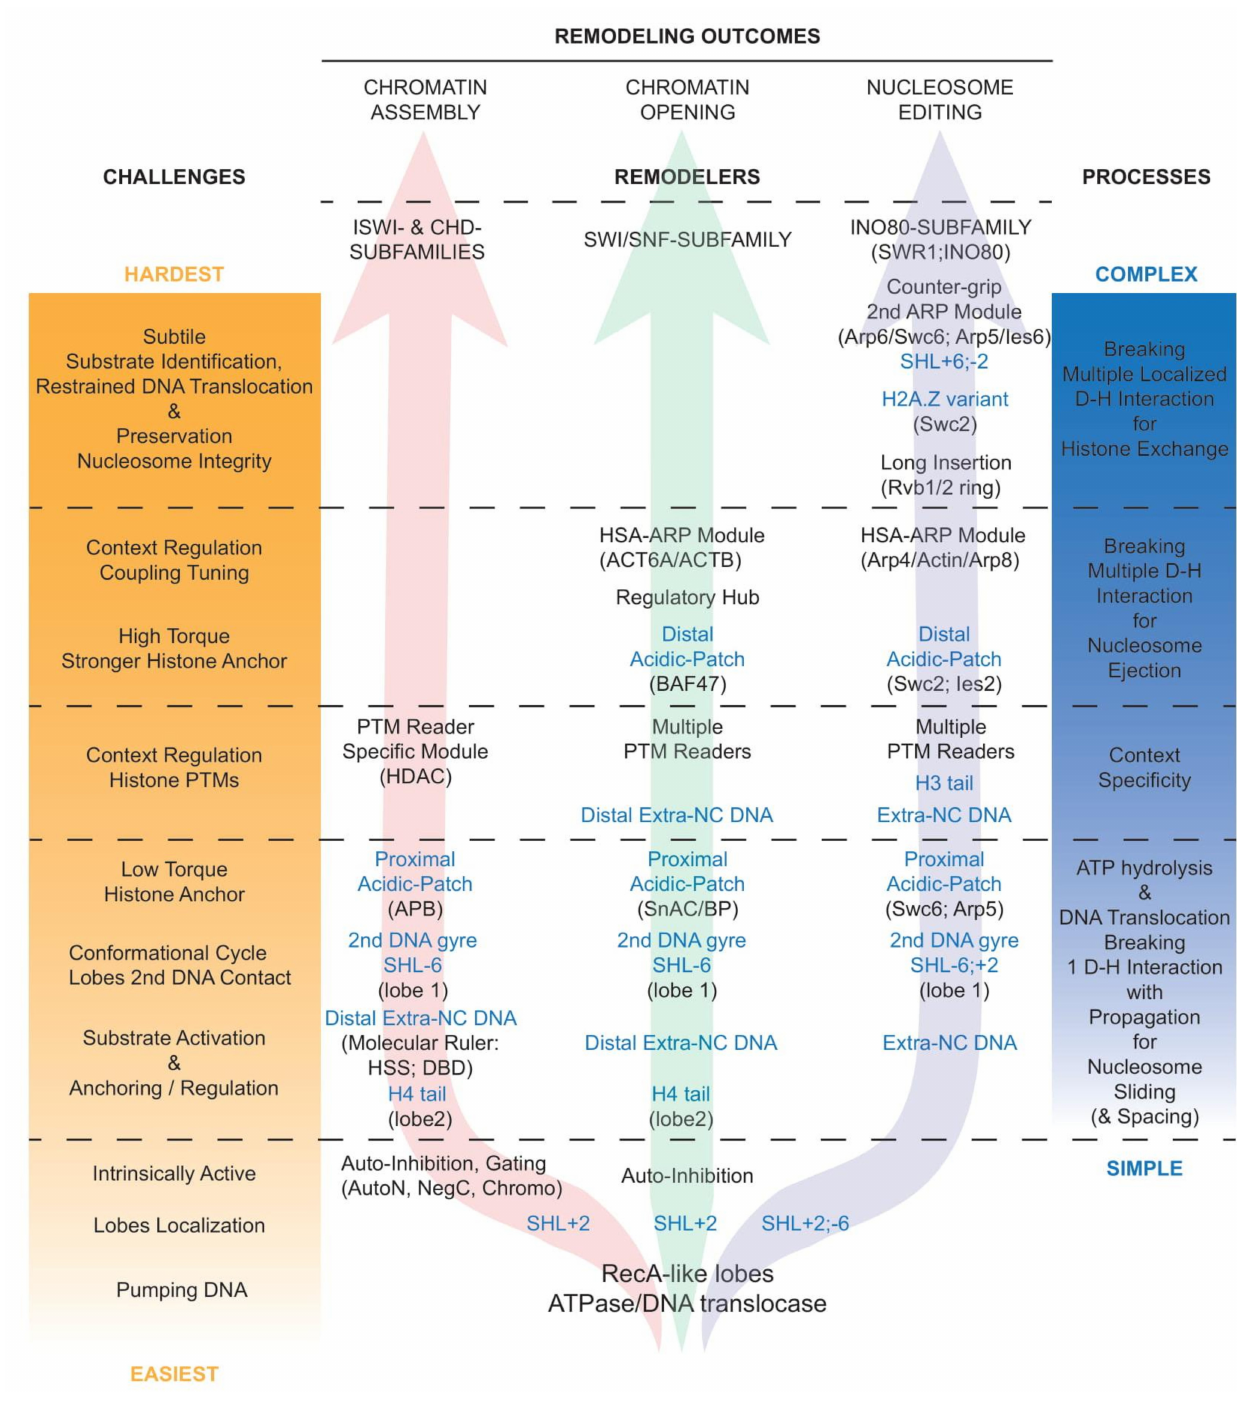
Figure 4. Hand-in-hand progressive increase in complexity of the regulatory conversations between remodelers and nucleosomes with the increase in challenges of remodeling processes. On the way (arrows) to successfully achieve their respective remodeling outcomes (top), remodelers from each subfamily need to overcome challenges (left orange gradient) associated with the processes they carry out (right blue gradient) by using shared and specific subunits and domains (black text along the arrows) corresponding to distinct nucleosomal features (blue text along the arrows). There is a positive correlation: the more complex the process is, the more challenges need to be overcome, and the higher is the need for complex regulation and multiple contacts with the nucleosome, and thus the more structurally and compositionally complex the remodelers are. D–H interaction stands for DNA–histone